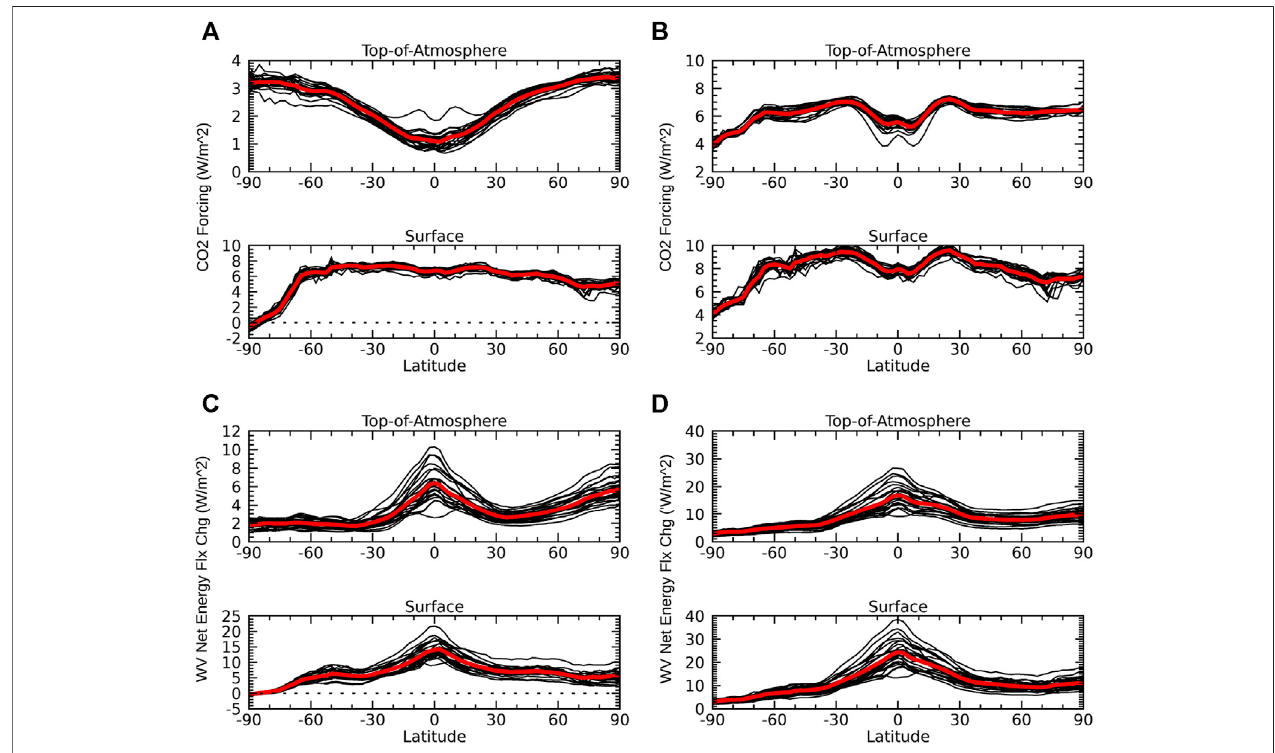
FIGURE 5 | The contributions of the (A) CO 2 forcing and (C) water vapor feedback to the net energy fl ux change (W*m − 2 ) associated with the lapse-rate and atmospheric temperature feedbacks at the TOA and surface, respectively. The sum of (A) and (C) with their direct effects ( Figures 2A,B , respectively) gives the total energy fl ux change (W*m − 2 ) due to the (b) CO 2 forcing and (d) water vapor feedback at the TOA and surface. Individual CMIP5 models (black lines); CMIP5 ensemble mean (red lines).